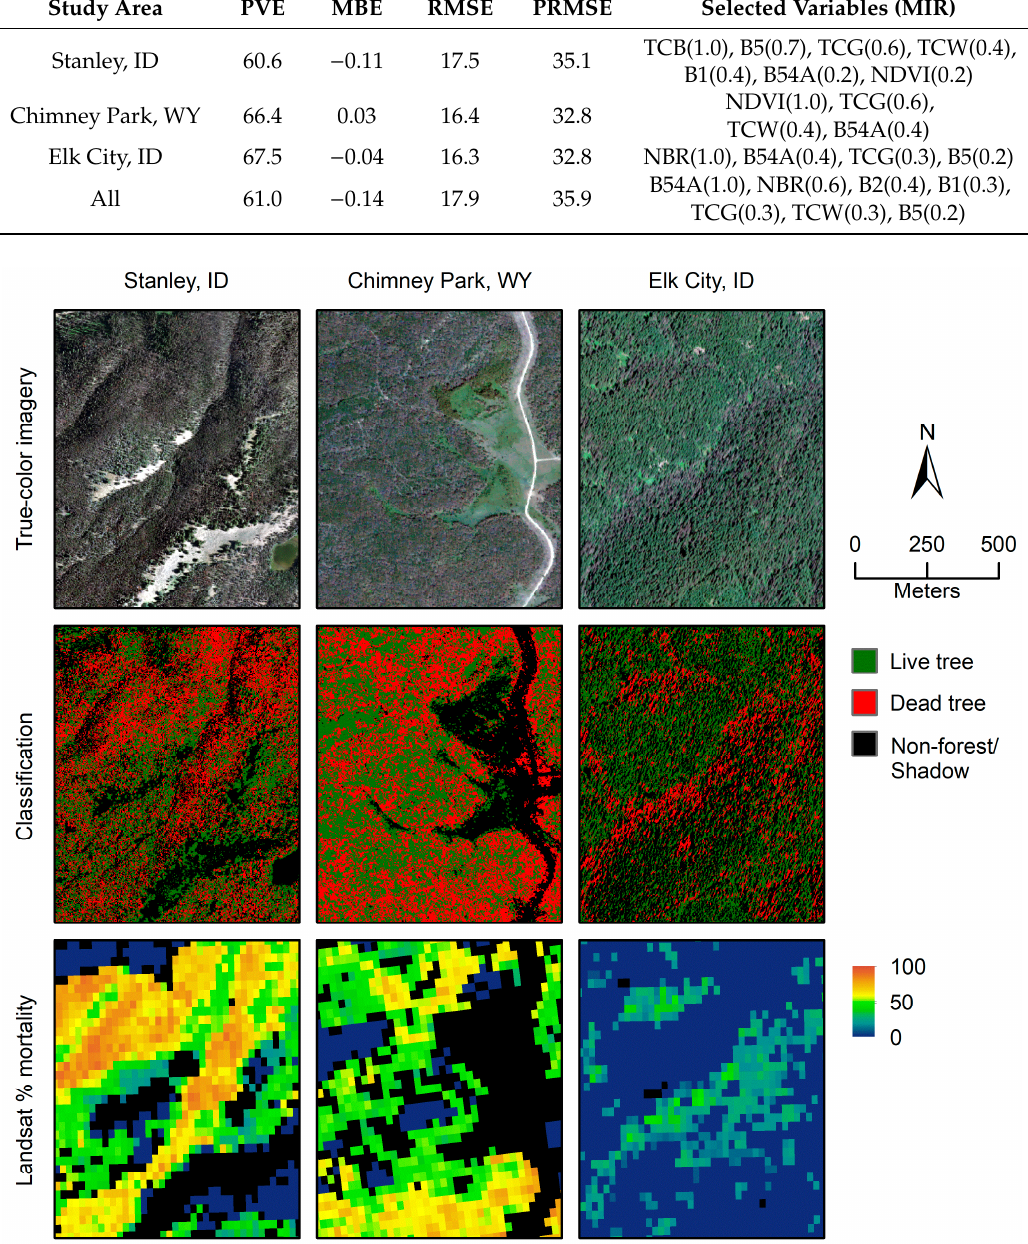
Figure 5. Comparison of true-color high-resolution imagery, high-resolution classifications, and mortality as estimated by Landsat variables in random forest (RF) percent mortality as estimated by Landsat variables in random forest (RF) models.